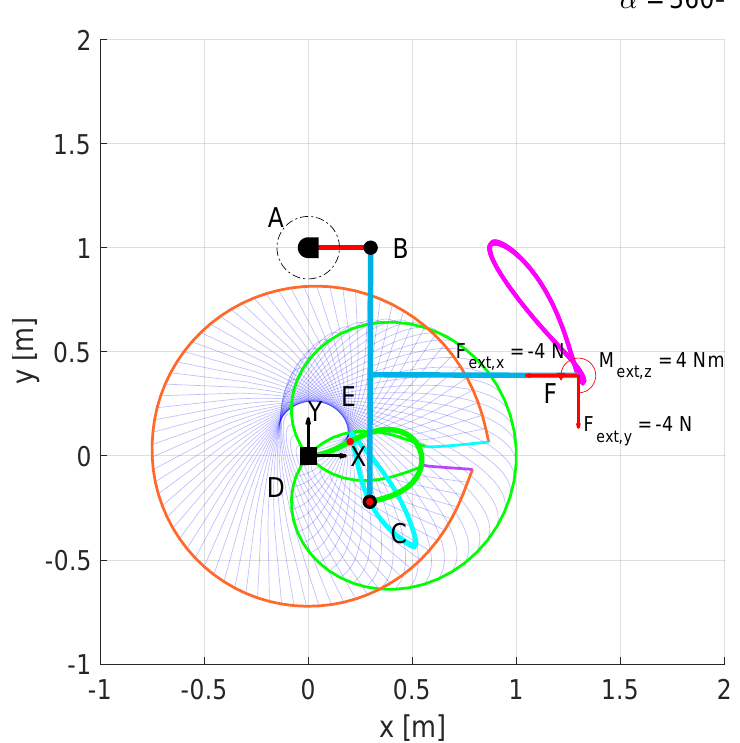
Figure 20. Second mechanism circuit under external loading of F ext , x = − 4 N, F ext , y = − 4 N, and M ext , z = 4 Nm. Final position and